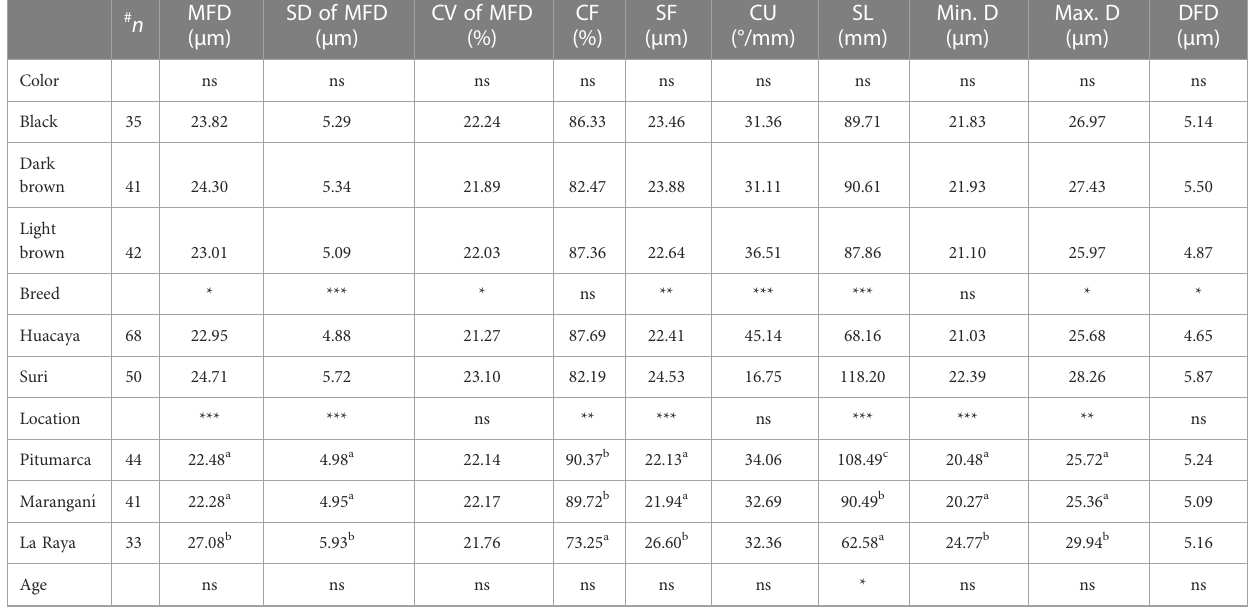
spinning fi neness than Suris ( p < 0.01). The mean fi ber curvature (Table 2) is signi fi cantly greater in Huacayas ( p < 0.001) than in Suris, but is not in fl uenced by other factors ( p > 0.05) such as fi ber color, location, age, and sex. TABLE 2 Effect of color, breed, location, age, and sex on the quality and staple length in